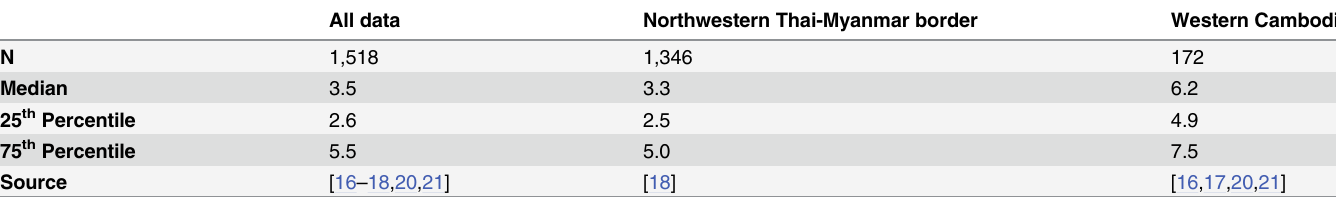
Table 2. Summary of the data stratified by country.